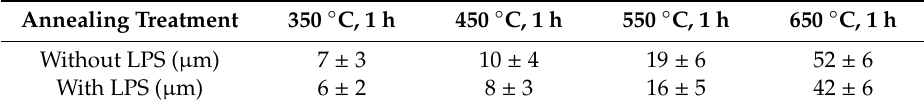
Table 3. Average grain sizes of the copper foils under different conditions.